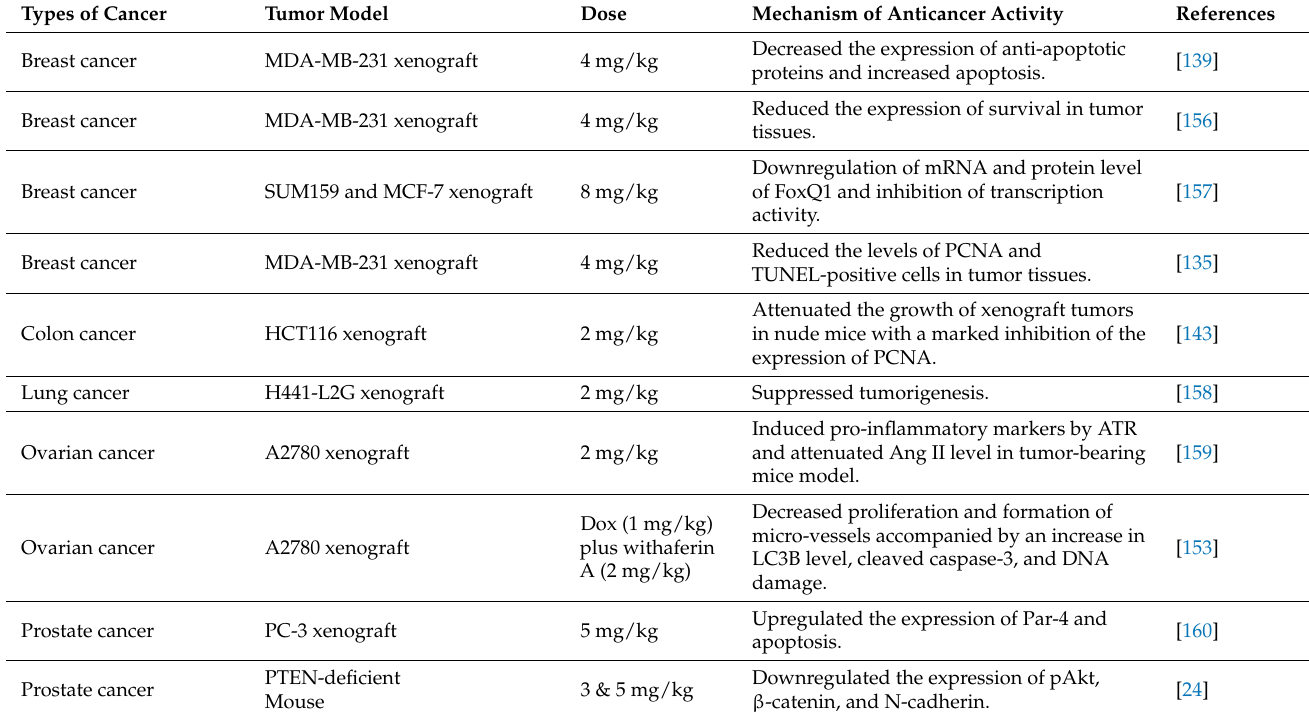
Table 2. Anticancer effects of withaferin A based on selected in vivo